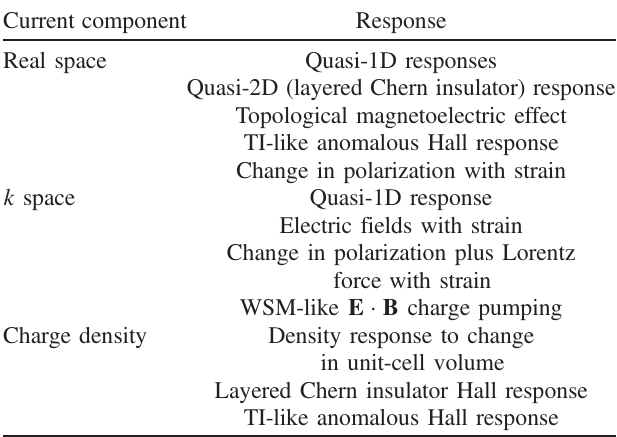
TABLE IV. Summary of 6D phase-space responses. Current